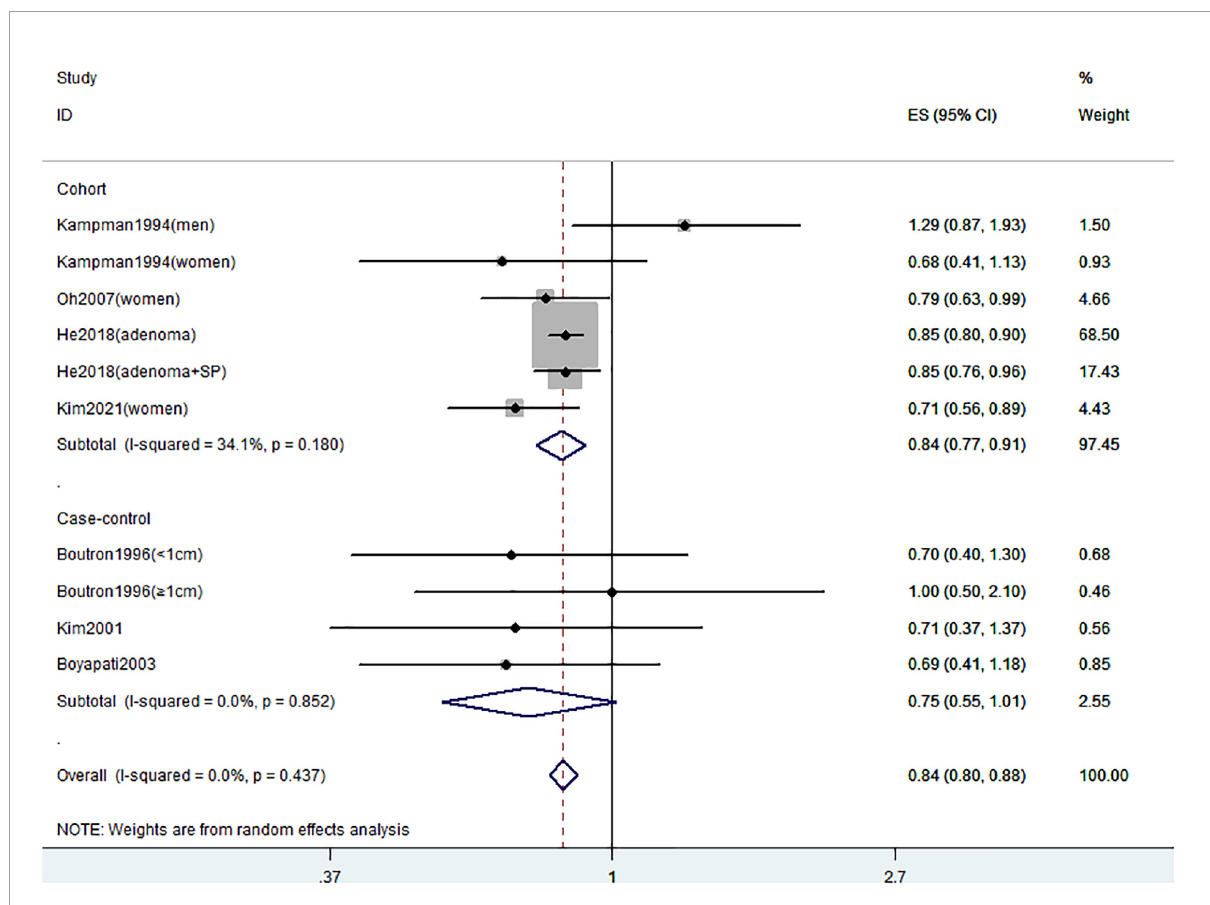
FIGURE2 Random-effects meta-analysis of studies that examined total vitamin D intake and risk of CRC precursors incidence. ES, effect